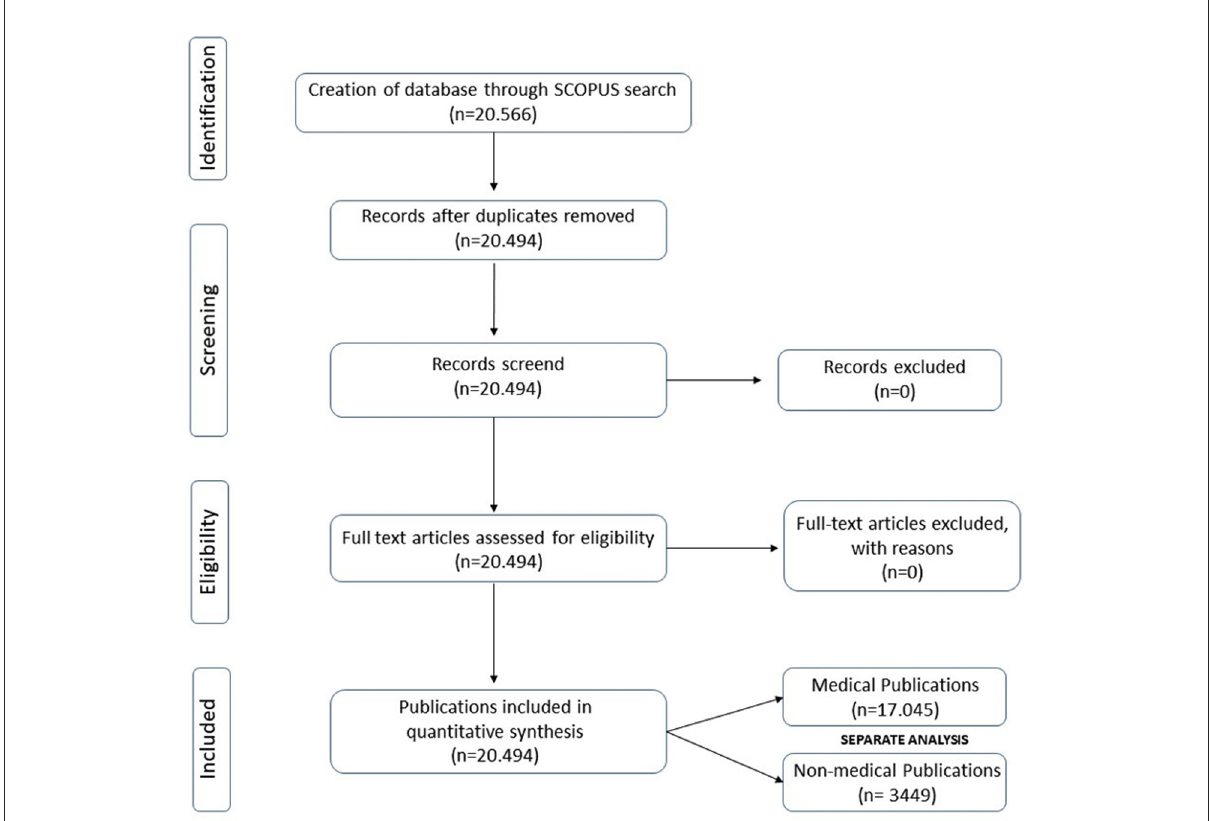
FIGURE1 SRQR flow diagram of the identification, screening and inclusion of source documents. Publications were subsequently separated in to medical and non-medical documents for further analysis.